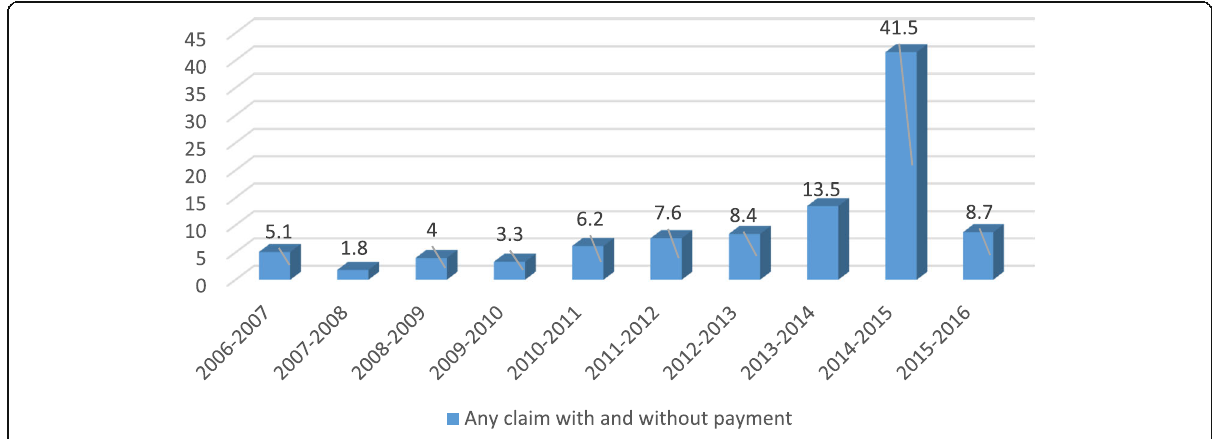
Fig. 2 Trends in overall claims, according to 10 years during the period from 2006 to